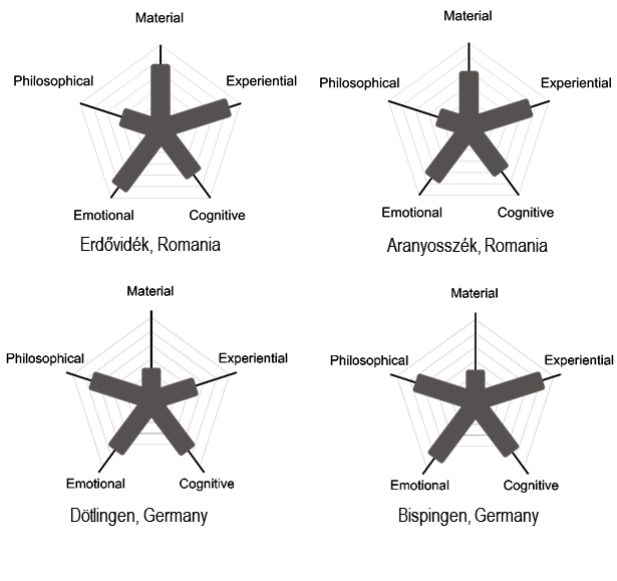
Fig. 3. Schematic depiction of the current strength of material, experiential, cognitive, emotional, and philosophical connectedness in the four focal areas of Erd ő vidék, Aranyosszék, Dötlingen, and Bispingen. Bars are a subjective interpretation based on the collective interview statements from each focal area and depicted here schematically to allow comparison among the focal